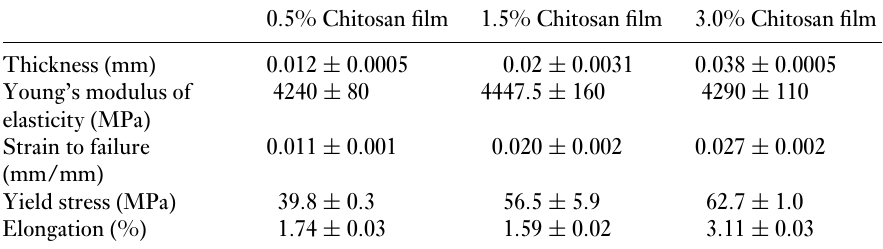
Table 1 Summary of tensile properties of chitosan films